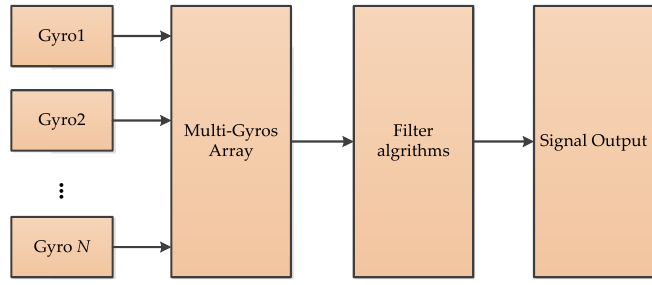
Figure 10. The principle of virtual gyroscope.